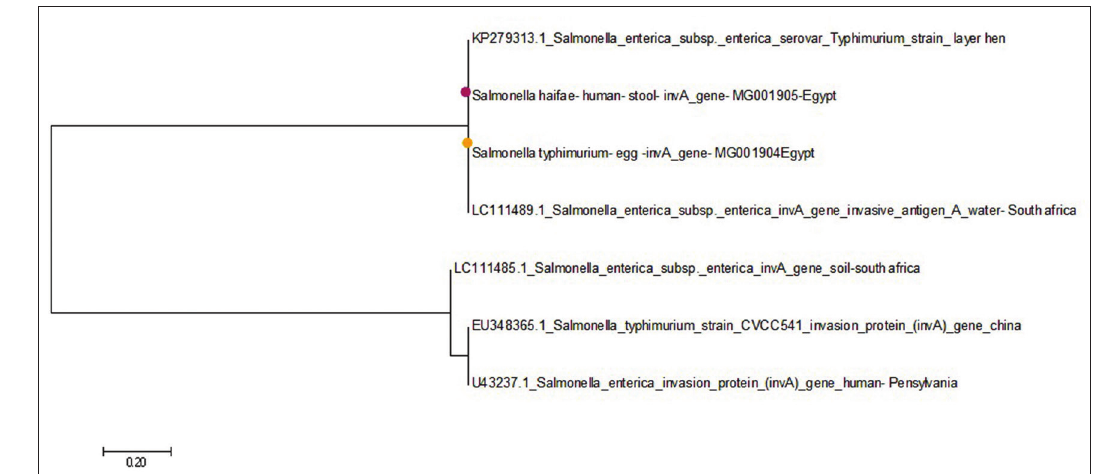
Figure-1: A phylogeny of Salmonella subspecies using the sequences of invasion invA